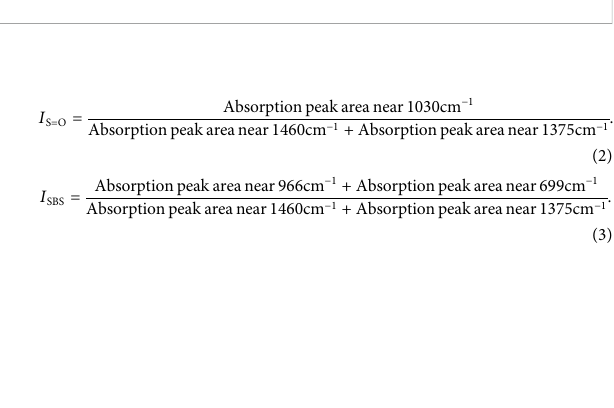
FIGURE 5 FTIR spectra of the samples under investigation (cf. Table 3 for